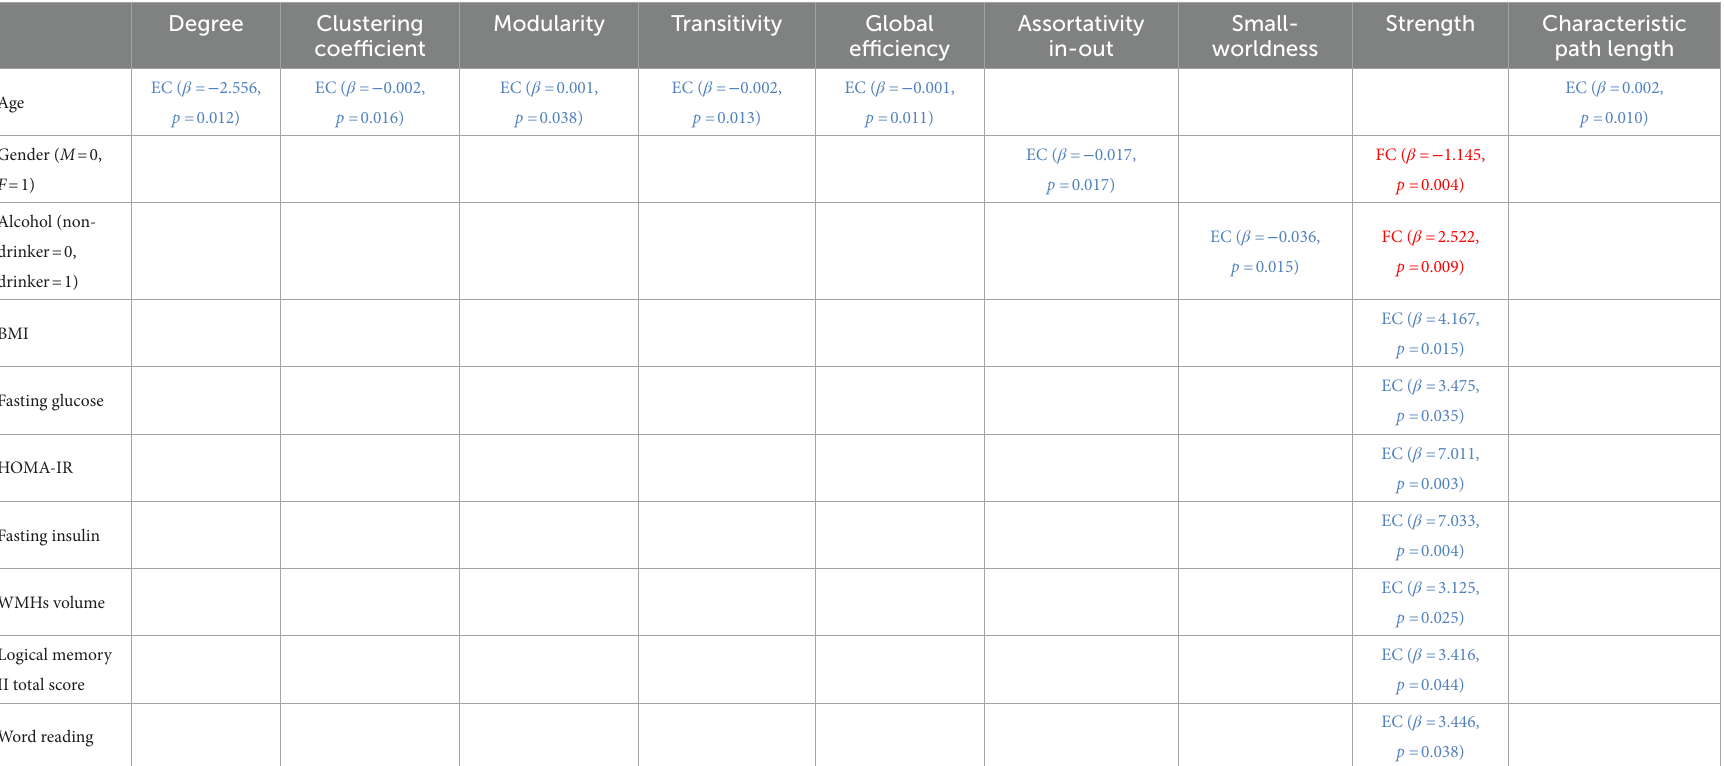
TABLE 4 Linear relationships between demographic, cardiometabolic, and cognitive measures and graph metrics derived from EC and FC for resting-state